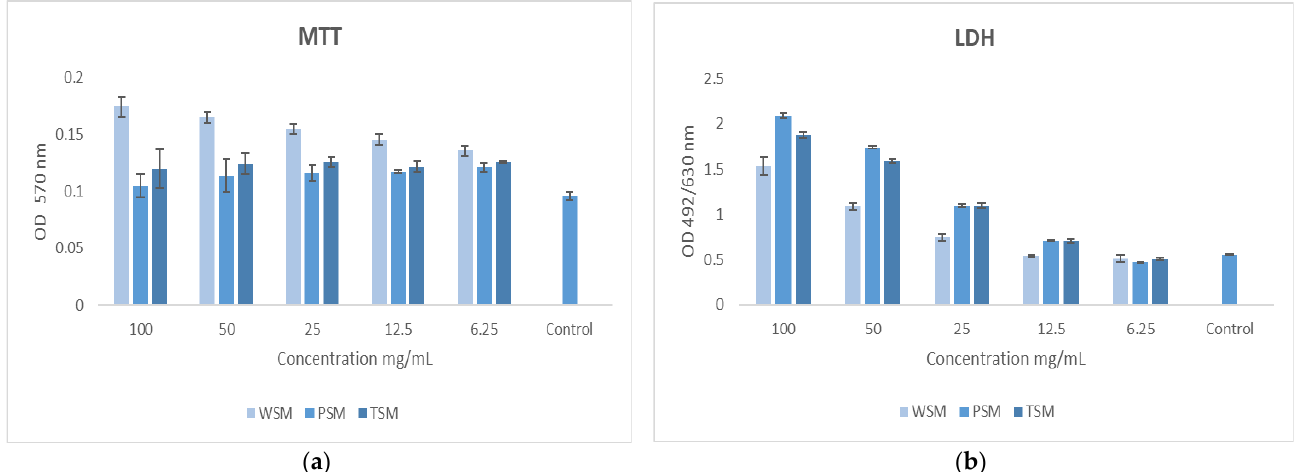
Figure 1. ( a ) Assessment of cytotoxicity using MTT; ( b ) assessment of cytotoxicity using LDH assay. Control is represented by L929 cells in culture media with PBS (samples solvent).